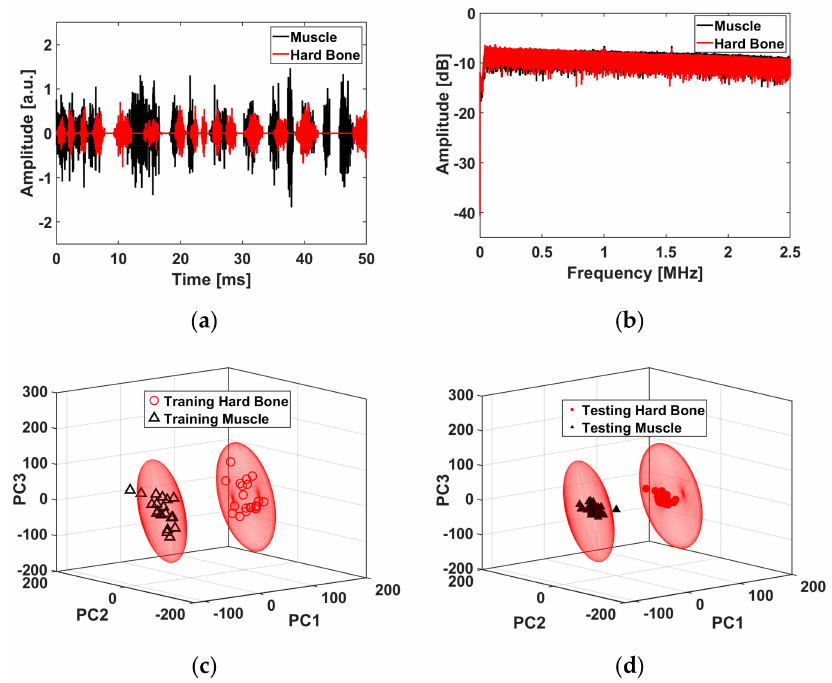
Figure 6. Acoustic shock wave di ff erentiation measured by a microphone during laser pulse energy at 7 J in wet conditions (Set 5): ( a ) ASW in the time domain, ( b ) Spectrum of the ASW, ( c ) Ellipsoids based on 20 scores from training data, ( d ) Classification of 30 scores from the test data in each ellipsoid of the training data.